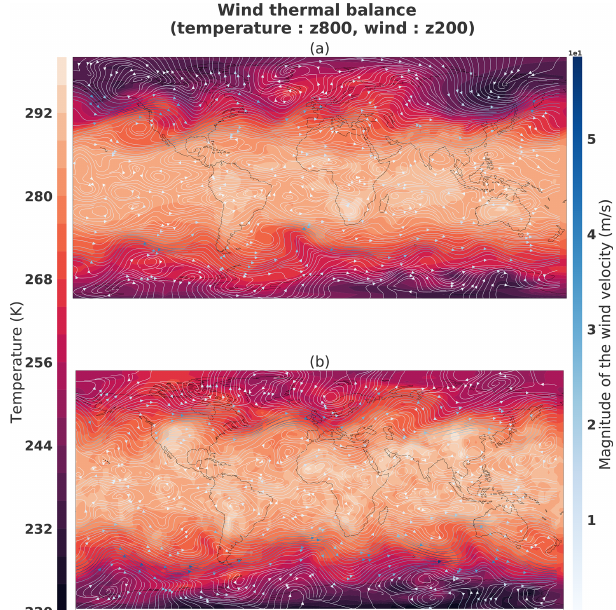
Figure 22. Thermal wind balance from the boreal winter situation shown in Fig. 21: (a) sample from the dataset; (b) sample generated by the generator. The temperature (K) is from pressure level 800hPa and the wind (ms − 1 ) from